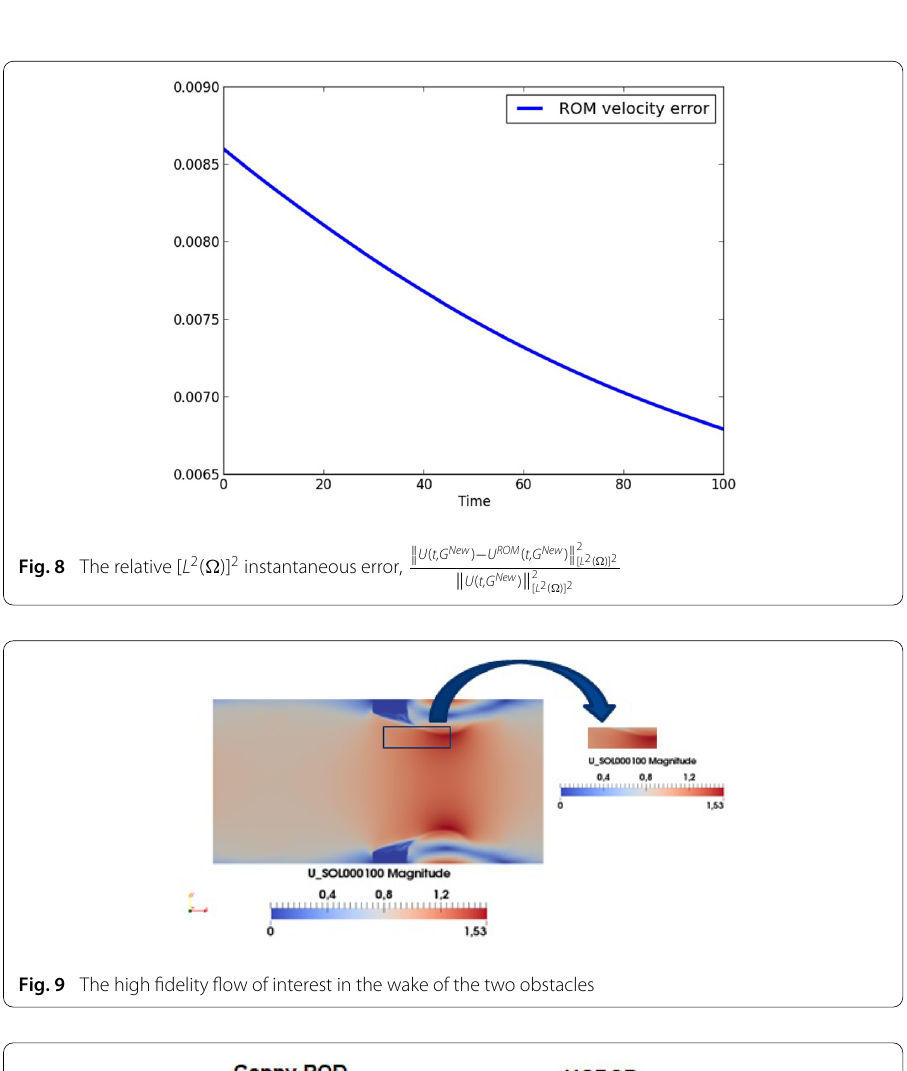
Fig. 9 The high fidelity flow of interest in the wake of the two obstacles